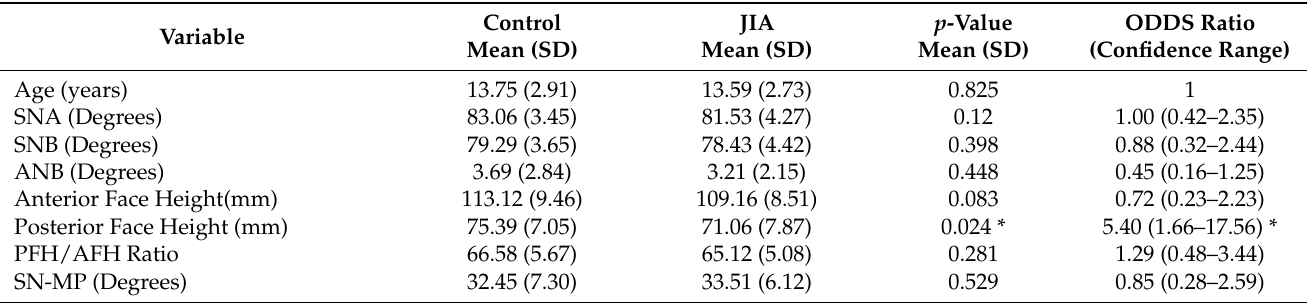
Table 1. Mean and standard deviation of each variable in control and JIA study groups, as well as p -value for statistical significance of unpaired Student t -test. In addition, the ODDS ratio was also calculated. * Indicates statistical significance